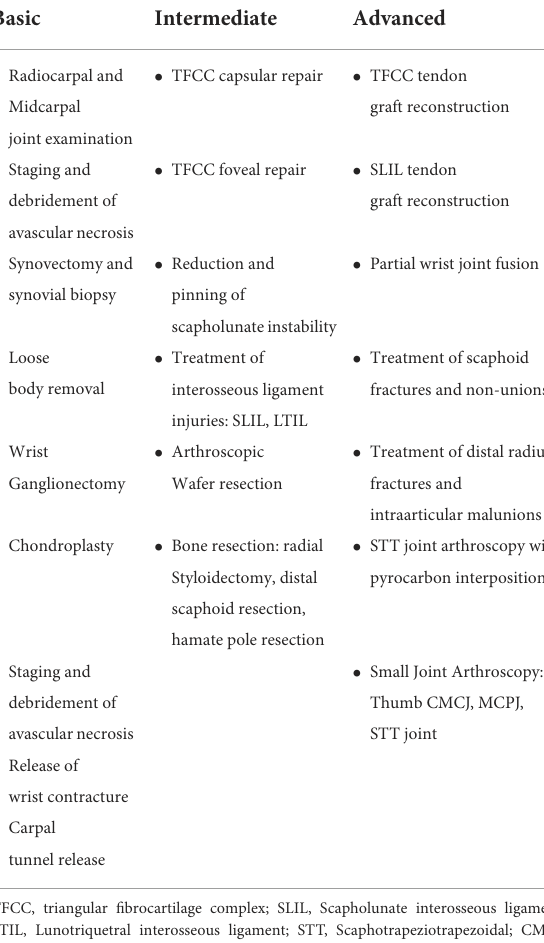
TABLE 1 Techniques in wrist and hand